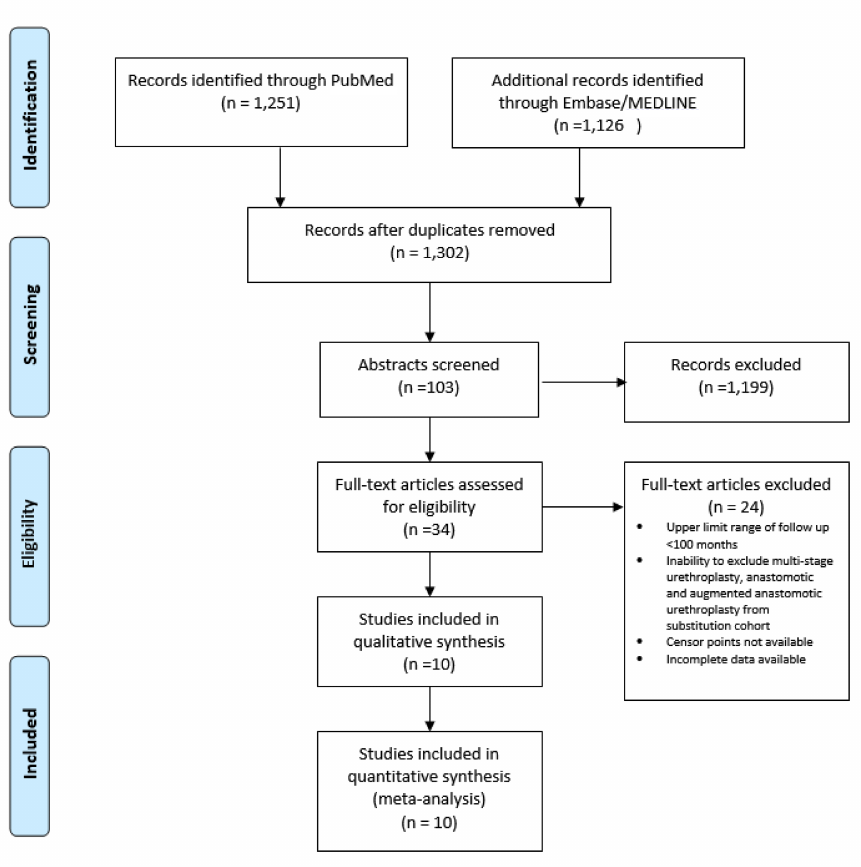
Figure 1 - PRIMSA Diagram for inclusion and exclusion of studies in the